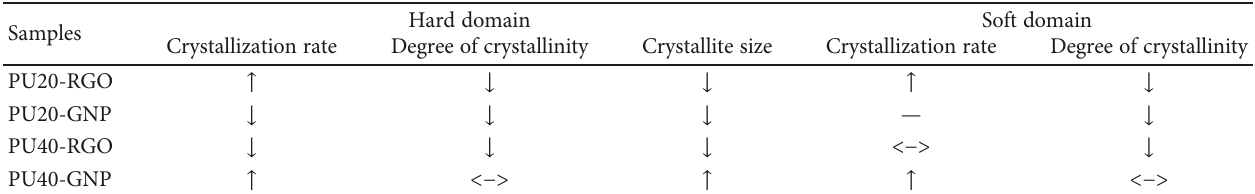
Table 6: Comparison of the nano fi ller ’ s in fl uence on PU hard and soft domains ’